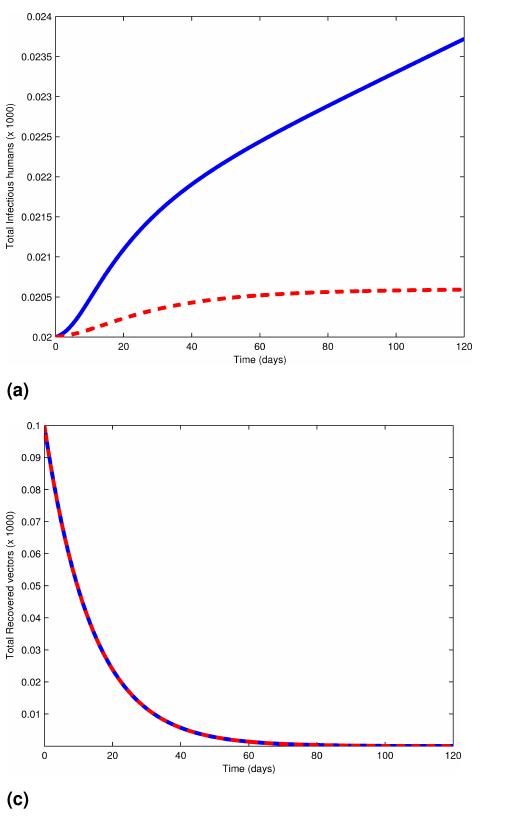
Fig. 3. Simulations of the leptospirosis model showing the effect of the optimal strategies: Prevention of humans and vaccination of vectors. The blue lines represent the cases without control, while the red lines indicate the cases with optimal